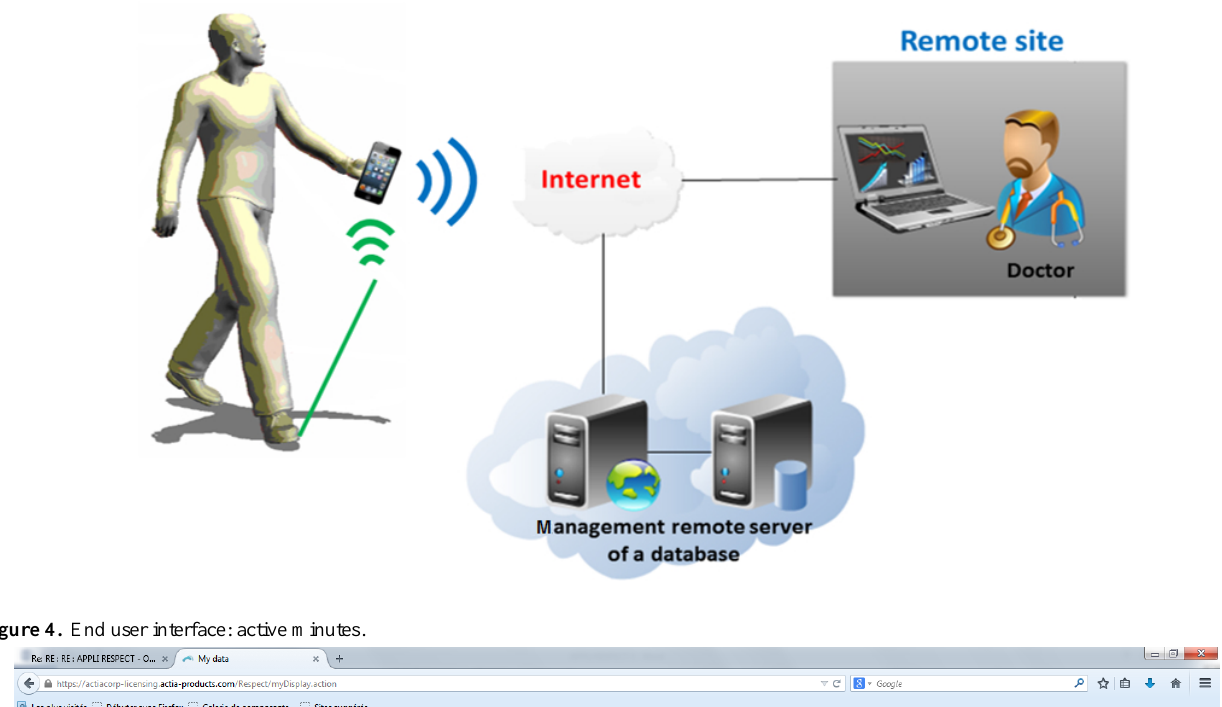
Figure 4. End user interface: active